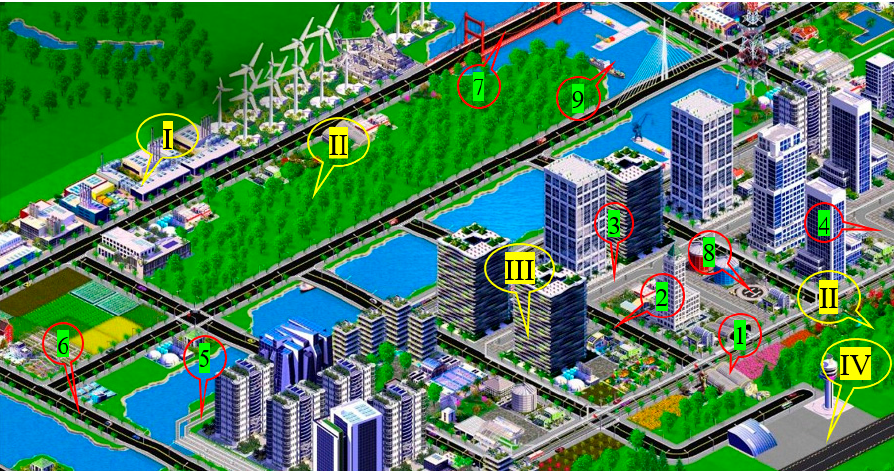
Figure 1. Urban total transportation system: I—industrial area (factories), II—forest area, III—urban area, IV—airport area, 1—underground, 2—road, 3—upper ground, 4—path, 5—railway, 6—highway, 7—freight transport, 8—urban air transport, 9—water transport.